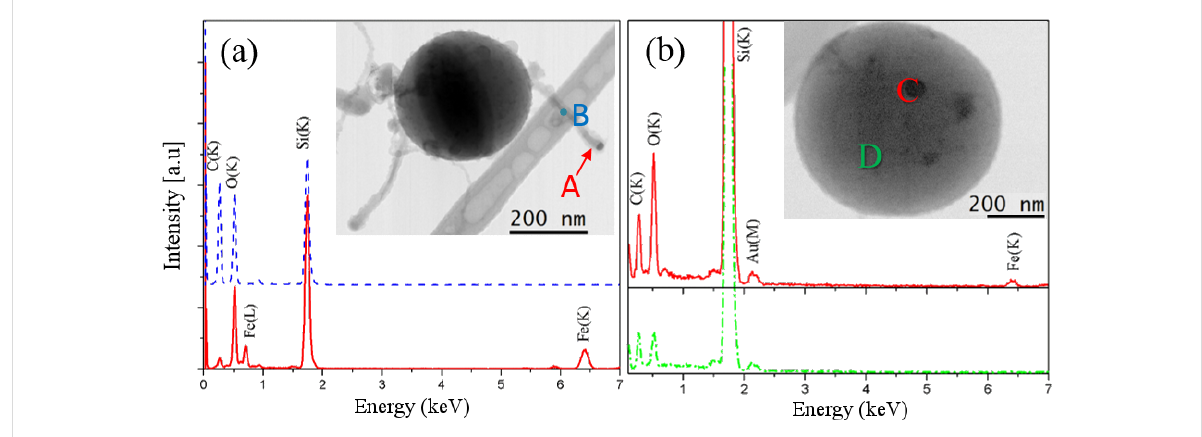
Figure 4: STEM-EDX spectra acquired at the points indicated in the BF STEM image in the insets: (a) SiNWs growing from the underling SiNS and (b) SiNS with Fe nanoparticles on the surface.